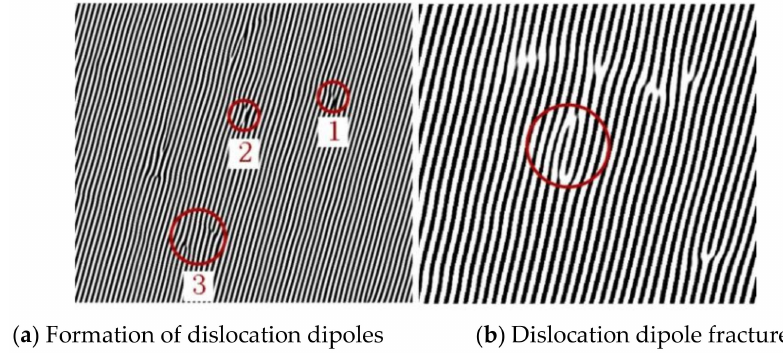
Figure 11. Formation and development of dislocation dipoles in the NV E690 cladding layer after